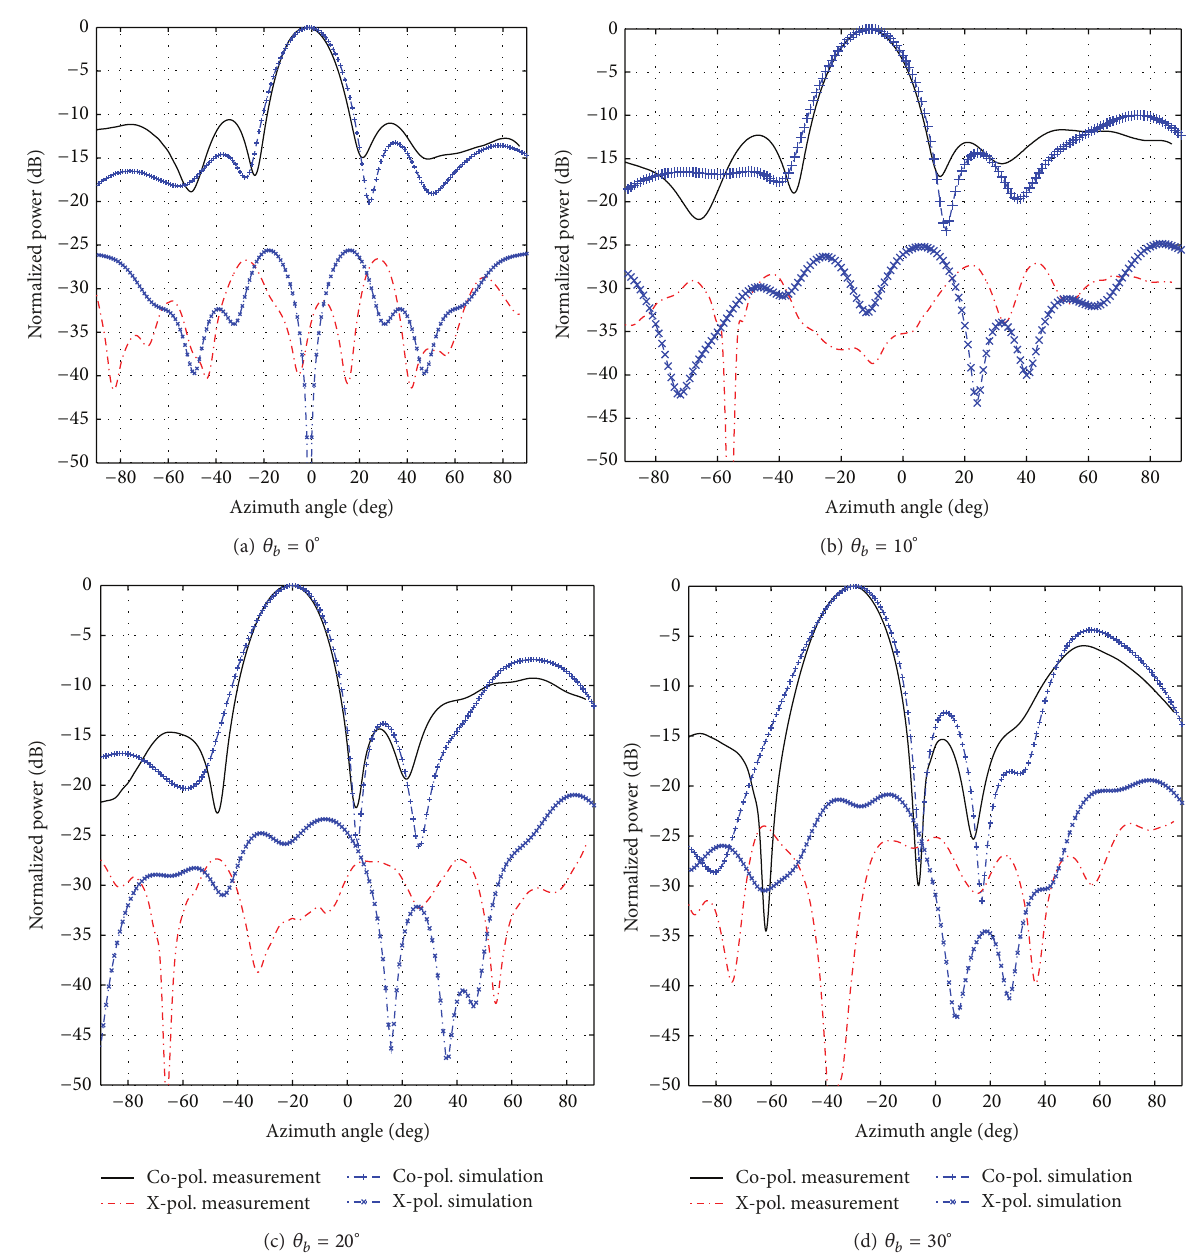
Figure 17: Measured 4-element circular array patterns. Beam-steering angle 𝜃 𝑏 is in azimuth direction. Simulations are performed using